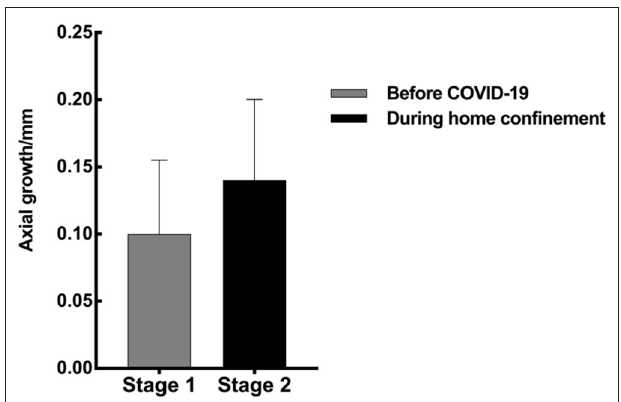
FIGURE 1 | Eye axial growth before and after the COVID-19 pandemic (in 3 months,